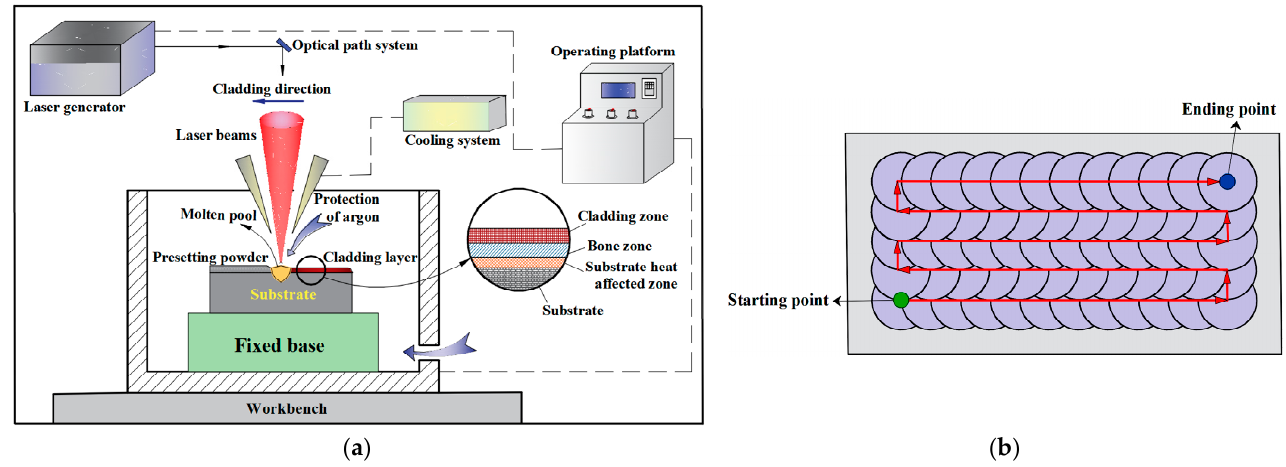
Figure 1. Principle diagram of the laser-cladding process: ( a ) laser processing process; ( b ) scanning path.